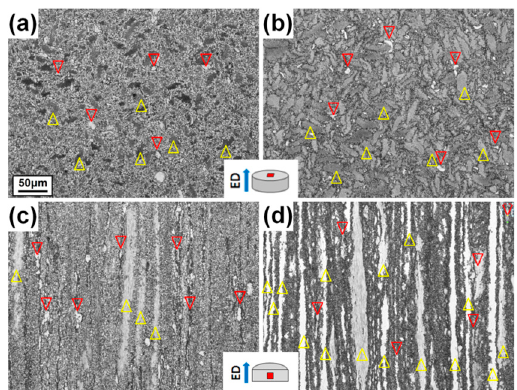
Figure 10. Optical micrographs of the as-extruded Mg-8.2Gd-3.8Y-1Zn-0.4Zr alloy taken from: ( a , b ) the transverse sections; and ( c , d ) longitudinal sections ( a , c ) A450; and ( b , d ) F450). The block-shaped phases and hot-worked grains are marked by red and yellow arrowheads, respectively